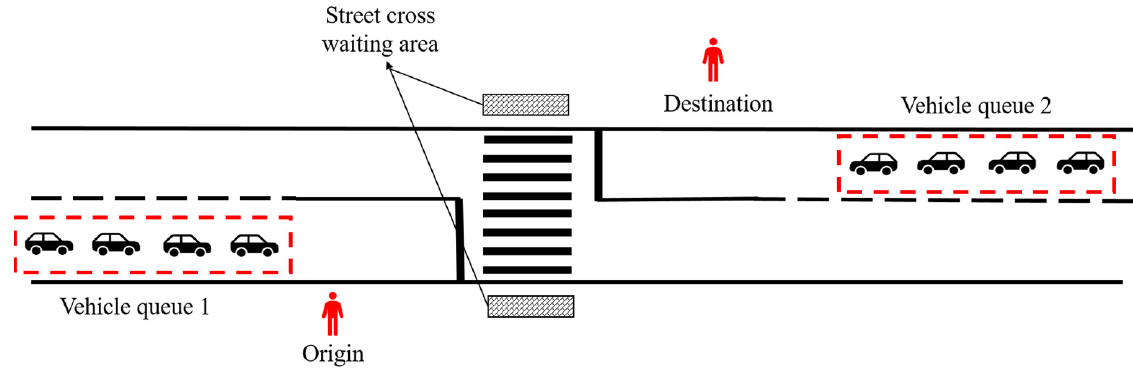
Figure 2. Schematic representation of the street crossing scenario.